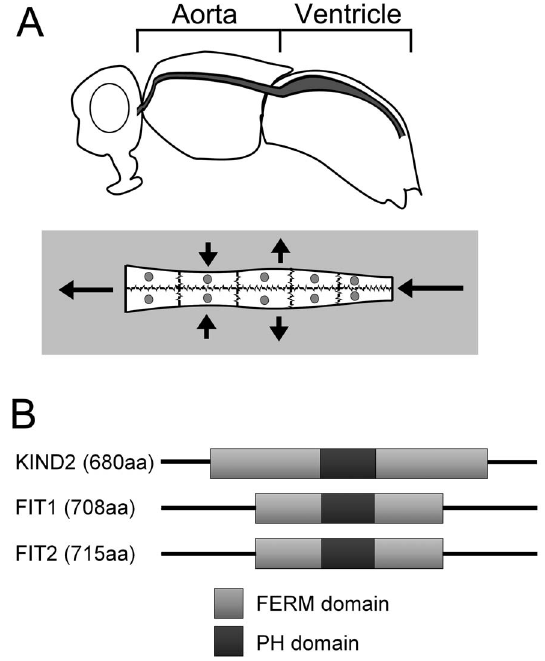
Figure 1. Overview of the adult Drosophila heart and Fermitins . ( A ) The schematic illustrates the position of the Drosophila heart (shaded grey) in the adult fly. The contractile portion of the heart (the ventricle) is within the abdomen and is connected directly to a non- contractile aorta which directs haemolymph (the insect equivalent of blood) from the abdomen, through the thorax and onwards to the head. The second schematic illustrates the ventricle, which consists of paired cardiomyocytes that function together as a single contractile syncytium (small arrows). Long arrows show the direction of circulation; however the heart can contract in different directions, so as to direct haemolymph to the fly’s anterior or posterior. ( B ) The integrin binding FERM domain of human Kind2 is present in both Fit1 and